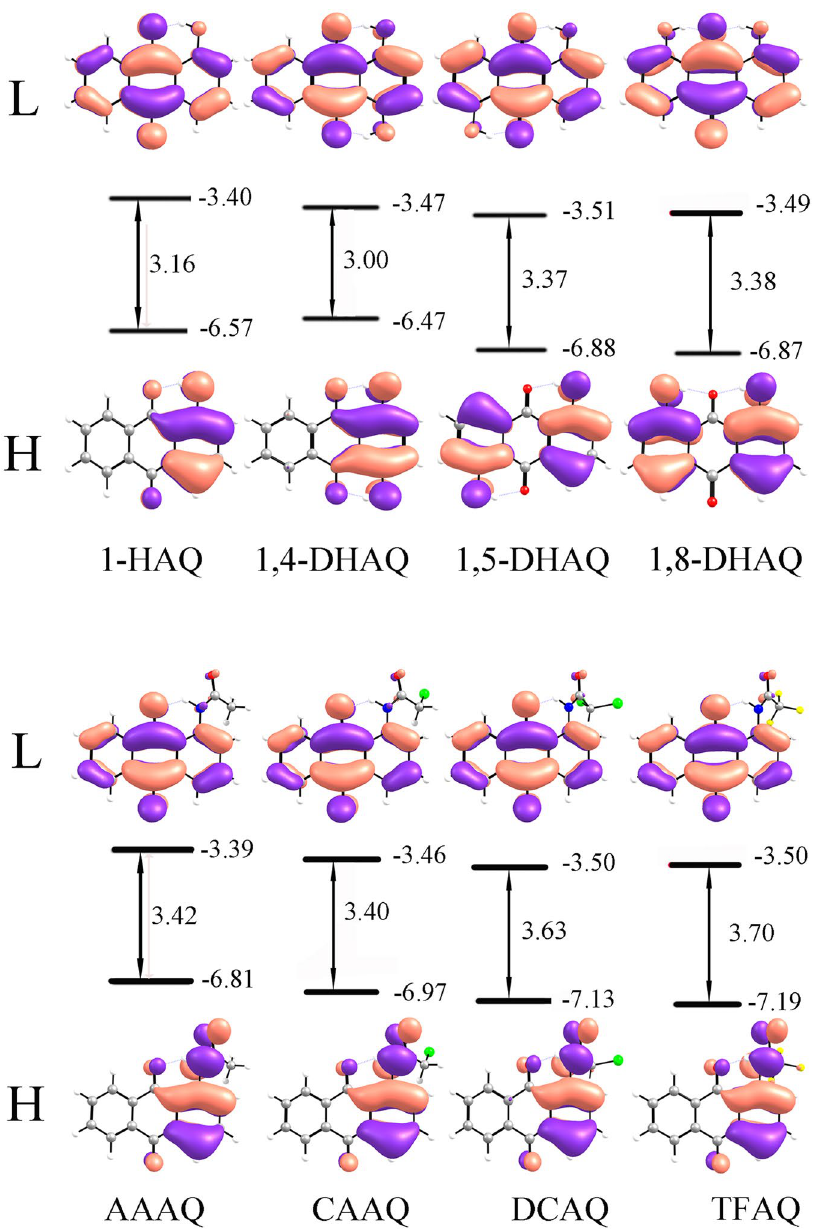
Figure 3. The schematic diagram of HOMOs and LUMOs for eight compounds and orbital energy levels (in